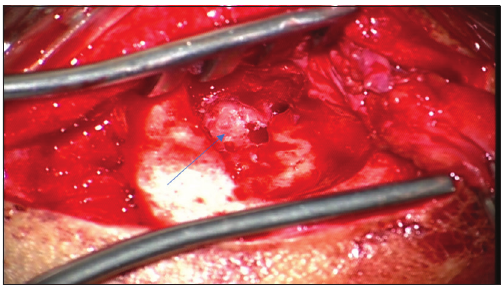
FIGURE 3. The arrow revealed the presence of cholesteatoma sac in the mastoid cavity during the mastoid